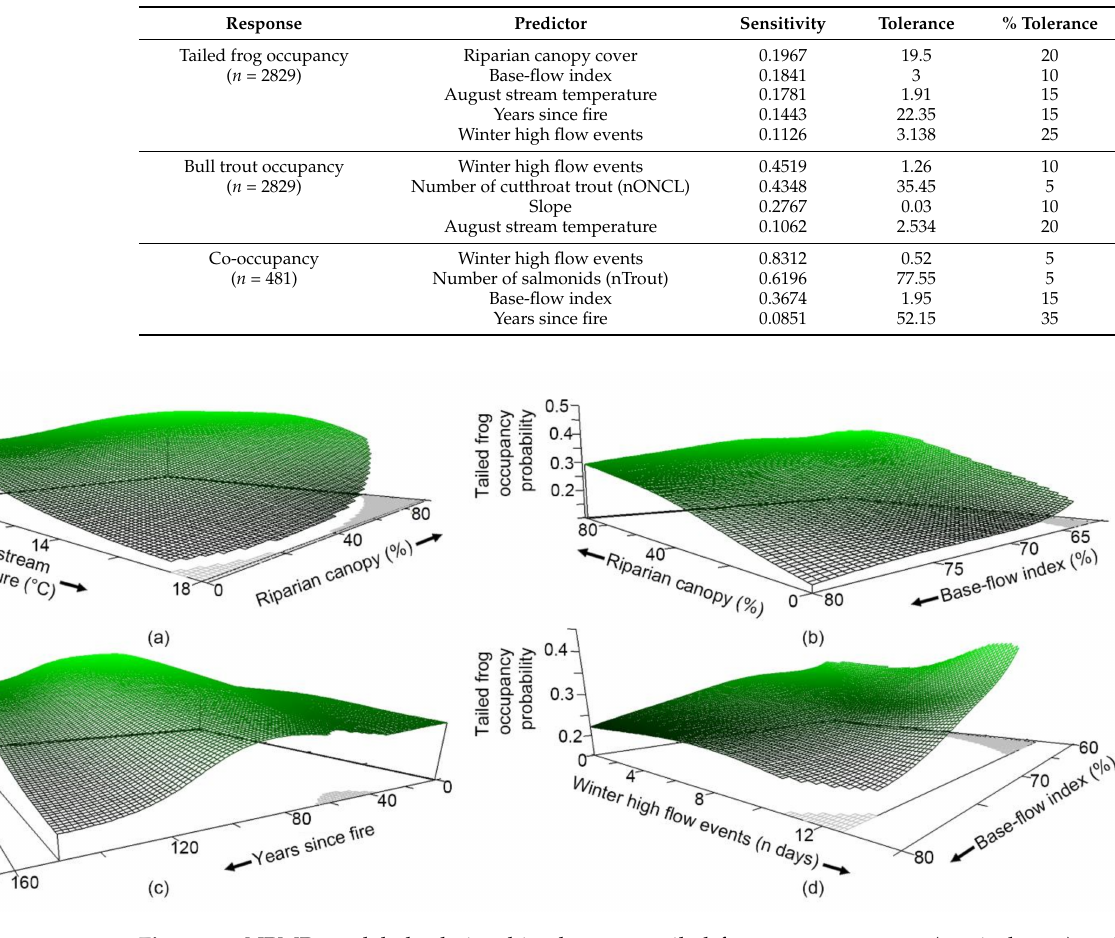
Figure 3. NPMR modeled relationships between tailed frog occupancy rate (vertical axes) and ( a ) mean stream temperature in August and riparian canopy cover, ( b ) riparian canopy cover and base-flow index, a measure of streamflow stability, ( c ) riparian canopy cover and number of years elapsed between wildfire and sampling year, and ( d ) winter high flow events (the number of winter days when stream flows are in >95 percentile of the flow of record) and base-flow index. This model was developed from 2829 sites sampled within the ranges of the Rocky Mountain tailed frog and bull trout. Gray shading in each panel indicates regions of predictor space with insufficient data for predictions to be